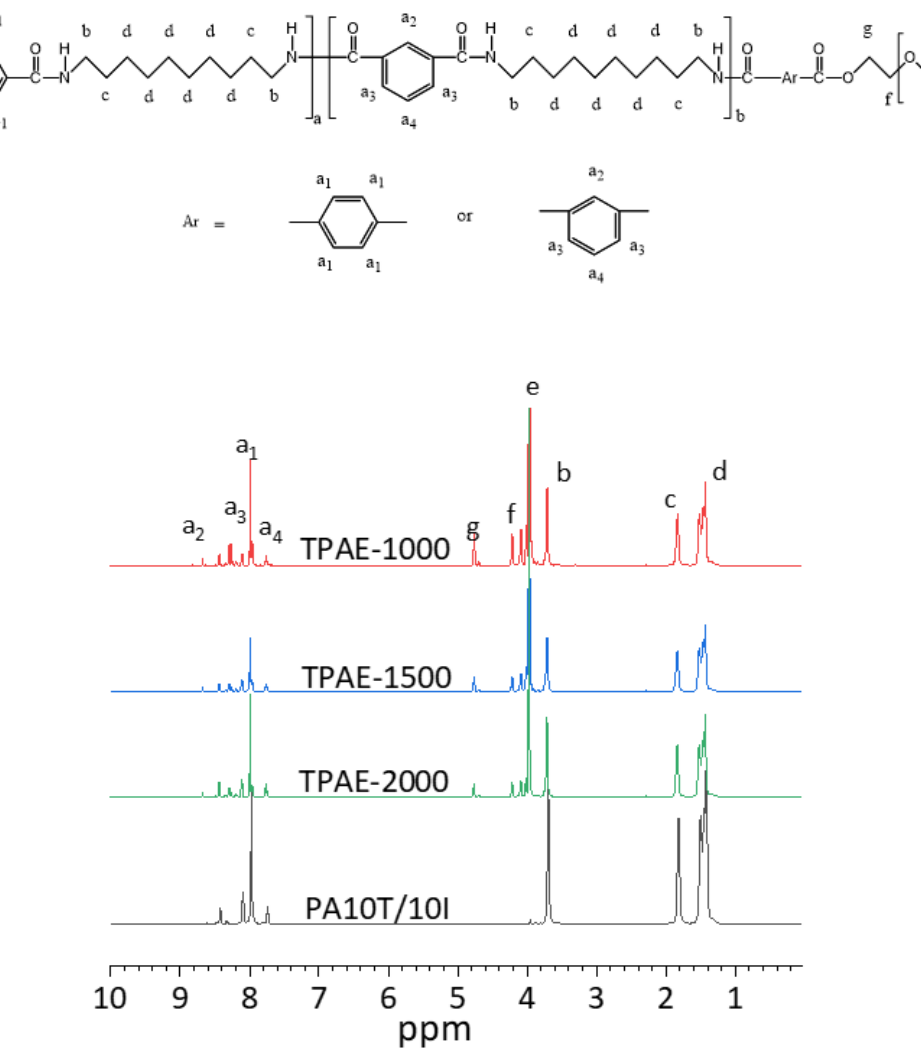
Figure 2. 1 H-NMR spectra of TPAEs and PA10T/10I.